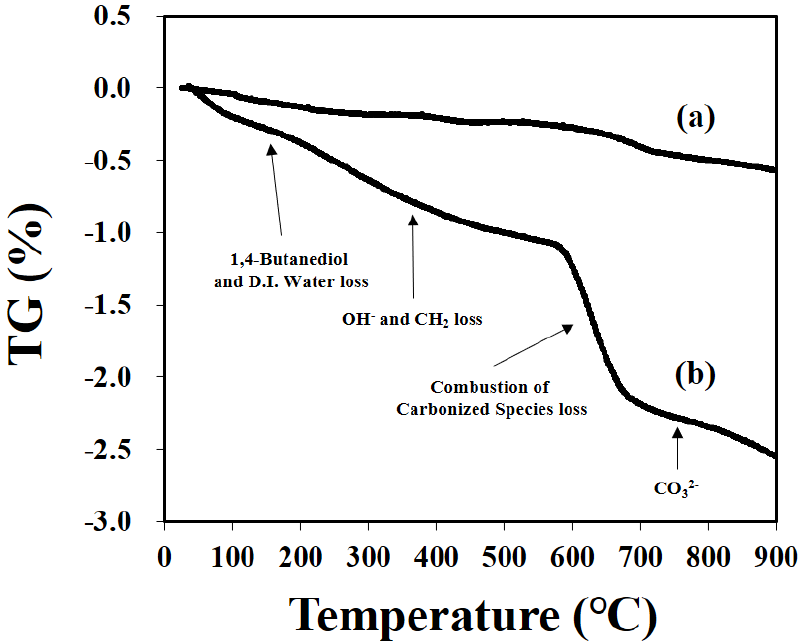
Figure 8. TG analysis of KNN particles synthesized by glycothermal treatment in different synthesis conditions: ( a ) pure hydrothermal and ( b ) pure glycothermal at 200 ◦ C for 12